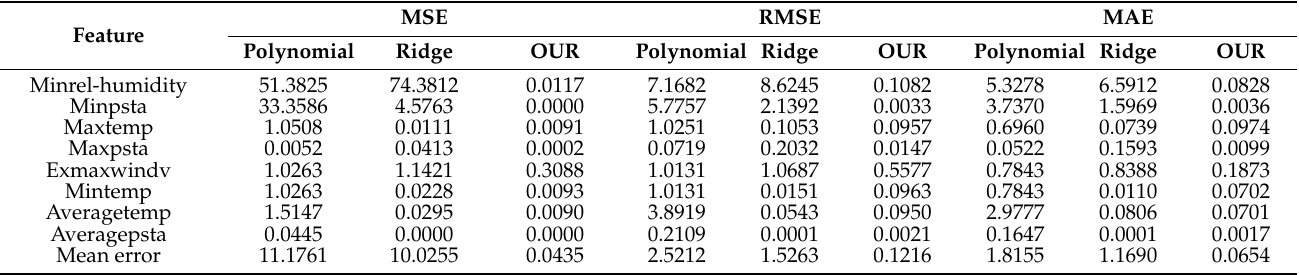
Table 6. Error comparison results of regression models